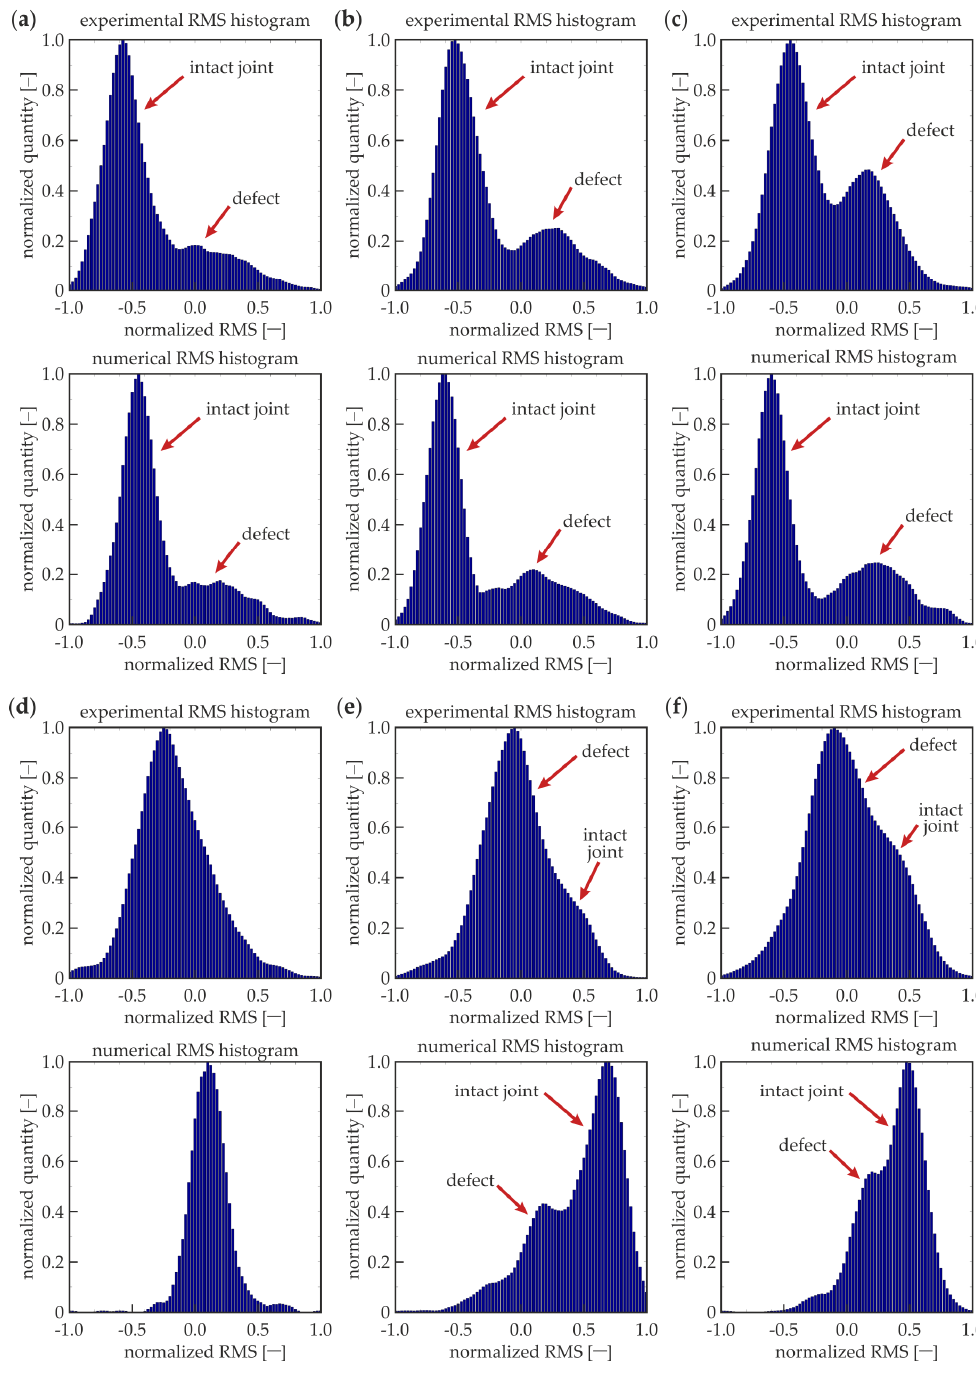
Figure 11. Experimental and numerical RMS histograms for different excitation frequencies: ( a ) f = 50 kHz; ( b ) f = 100 kHz; ( c ) f = 150 kHz; ( d ) f = 210 kHz; ( e ) f = 300 kHz; and ( f ) f = 350 kHz.